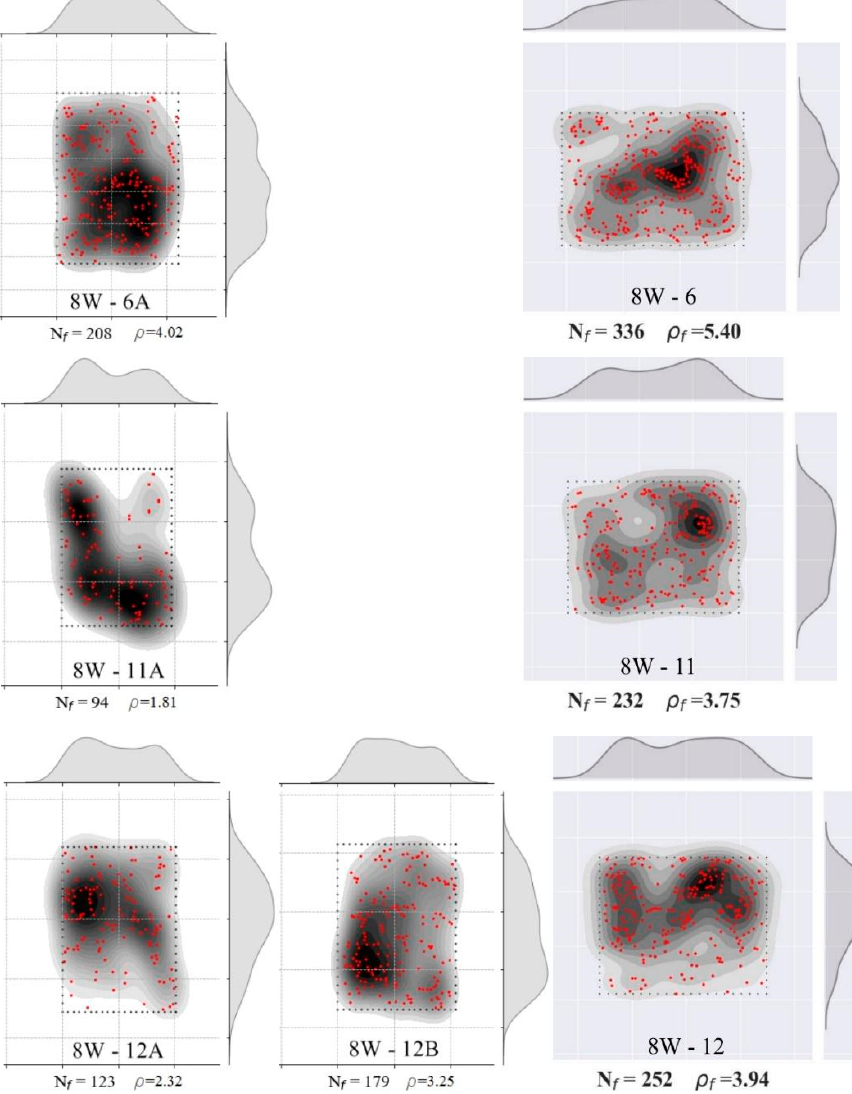
Figure 14. Fiber density and distribution of 8W specimens. Left column corresponds to prism A (shear), middle column corresponds to prism B (shear) and right column corresponds to the flexural case.